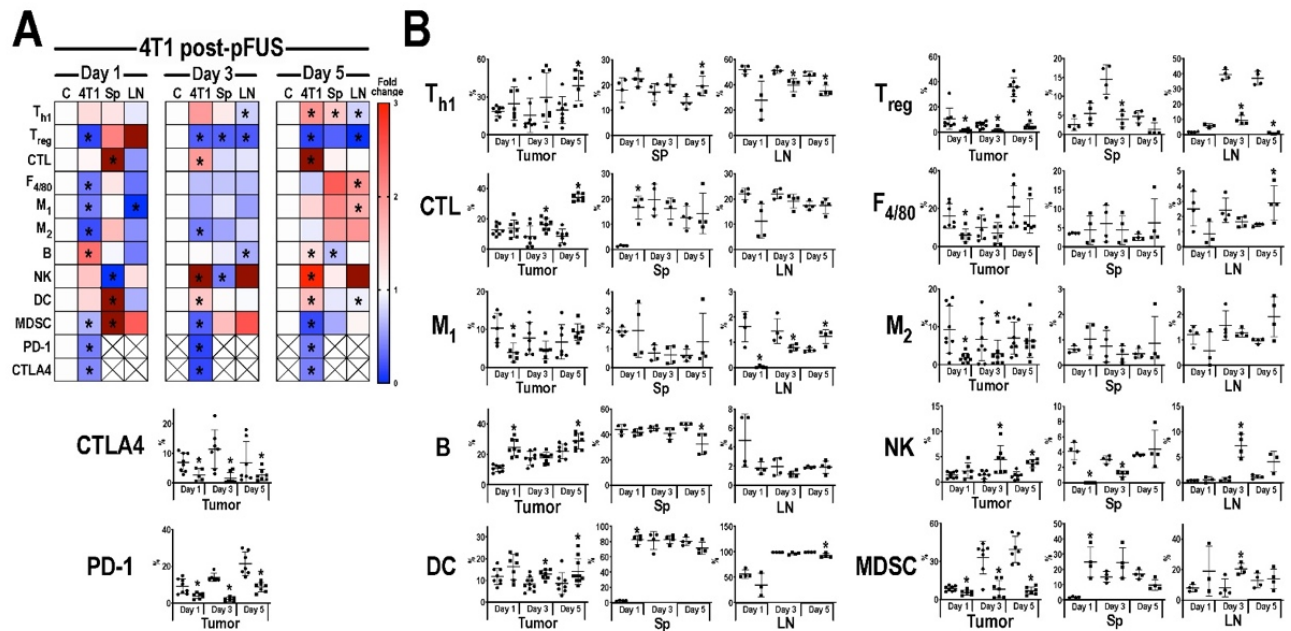
Figure 4. Immune cell profiling following pFUS in 4T1 tumors. ( A ) Heat map of flow cytometry analysis ( n = 6 mice/time point) results for 4T1 tumor (4T1), spleen (Sp) or lymph node (LN) compared to time-matched control tissues. Tissues were harvested 1 (left), 3 (middle) or 5 (right) days following pFUS; Increased fold changes are indicated in red while decreased fold changes are shown in blue. Fold change >3.1 is displayed as dark red; ( B ) Quantitative values of immune cell profiles (mean ± SD) of mouse 4T1, Sp, or LN, right, dissected 1, 3 or 5 days following pFUS. y -axis represents the relationship between each cell population to the total cells detected; x -axis represents days post-pFUS. Asterisks indicate statistical significance ( p < 0.05; ANOVA) between total cells detected in pFUS-treated mice (black squares) samples to time-matched controls (black circles). Helper T cells (T h1 ), cytotoxic T lymphocytes (CTL), regulatory T cells (T reg ), natural killer (NK) cells, dendritic cells (DC), F 4/80 macrophages (M 1 and M 2 ), myeloid-derived suppressor cells (MDSC), cytotoxic T-lymphocyte antigen 4 (CTLA4), programmed death-1 (PD-1), and programmed death-ligand 1 (PD-L1).